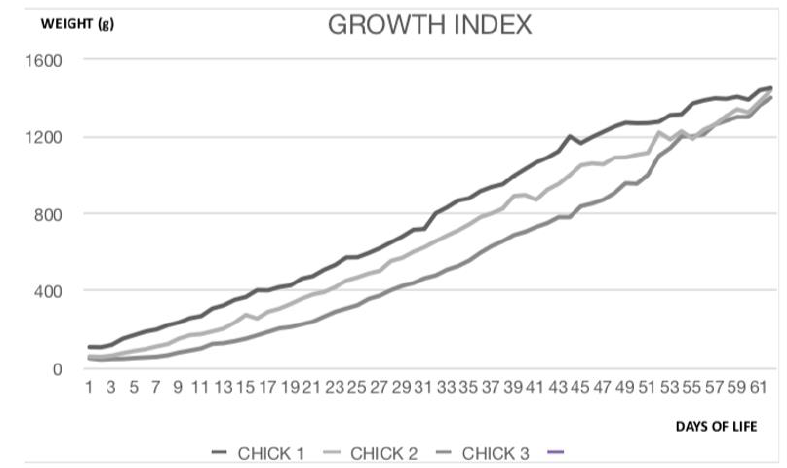
Figure 1. Daily growth data (for the first 60 days after birth) of lesser flamingo chicks of the present study.